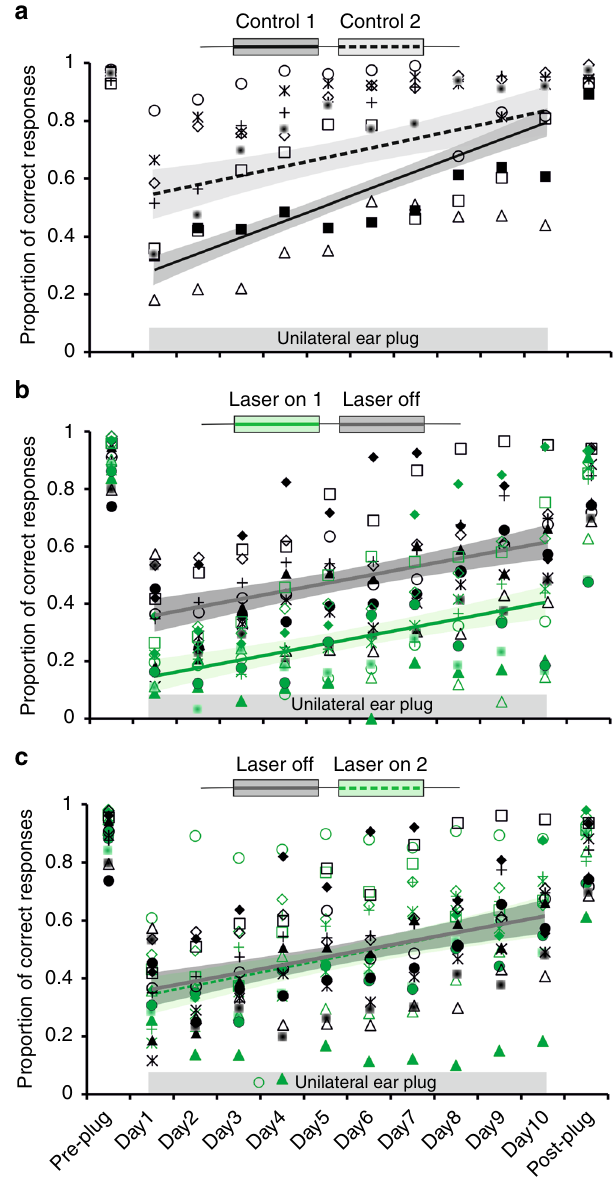
Fig. 6 Learning retrieval during successive periods of monaural occlusion. Proportion of correct responses (averaged across all speaker locations) is shown in the session before the right ear was plugged (Pre-plug), on each of the 10 days over which the plug was worn (days 1 – 10), and in the session following its removal (Post-plug). a Data from the control group ( n = 13) are shown for two 10-day periods of monaural occlusion: lines and shaded areas correspond to the best linear fi ts and 95% con fi dence intervals, respectively, while the symbols represent individual performance during the second period of monaural deprivation (individual animal data for the fi rst period are shown in Fig. 4b). b Data from the ferrets in which ArchT was expressed in high-frequency A1 ( n = 13) are shown for the fi rst two 10-day periods of monaural occlusion, with light delivered to the implanted optical fi ber to suppress cortical activity on every trial during the fi rst block (laser on 1, green), but not during the second block (laser off, gray). Colored symbols represent individual performance under each condition. c Data from the ferrets in which ArchT was expressed in high- frequency A1 for the second and third 10-day periods of monaural occlusion; the laser was off during the second block (gray, as in b , n = 13), but on during each stimulus presentation in the third block (laser on 2, green, n = 12). Note that perturbing cortical activity no longer has any effect on the localization accuracy of the animals. Source data are provided as a Source Data fi